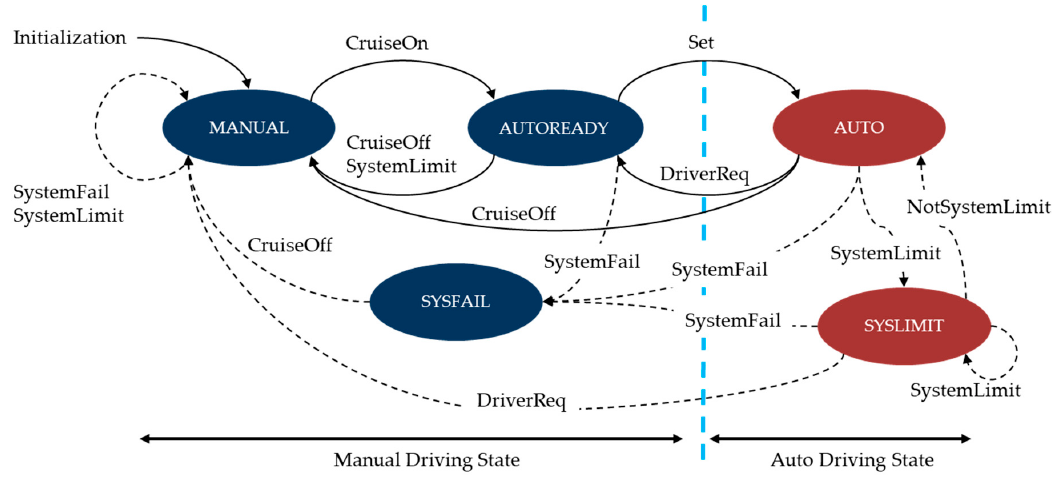
Figure 12. Driving states, modes, and transition diagram.